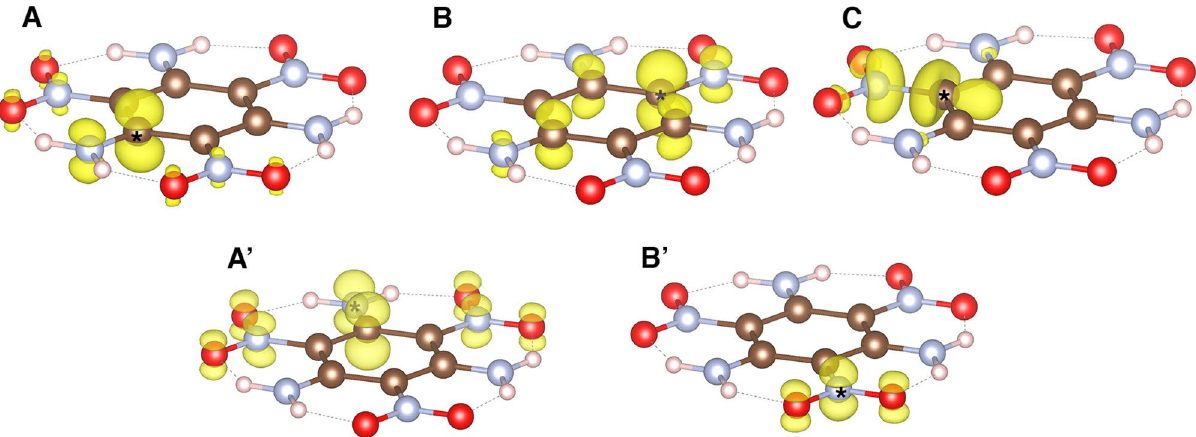
Figure 2. Excited state charge densities of carbon (top) and nitrogen (bottom) sites contributing to transitions as indicated in Fig. 1. Color code: Brown: carbon. Gray: nitrogen. Red: oxygen. White: hydrogen. Excited sites are indicated by an asterisk. Figures were made using VESTA 13